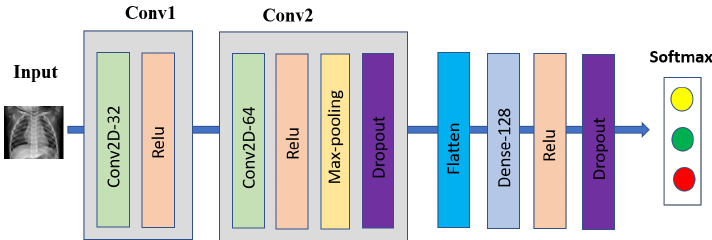
Figure 2. The 2D CNN with 3 × 3 convolutional layers architecture.